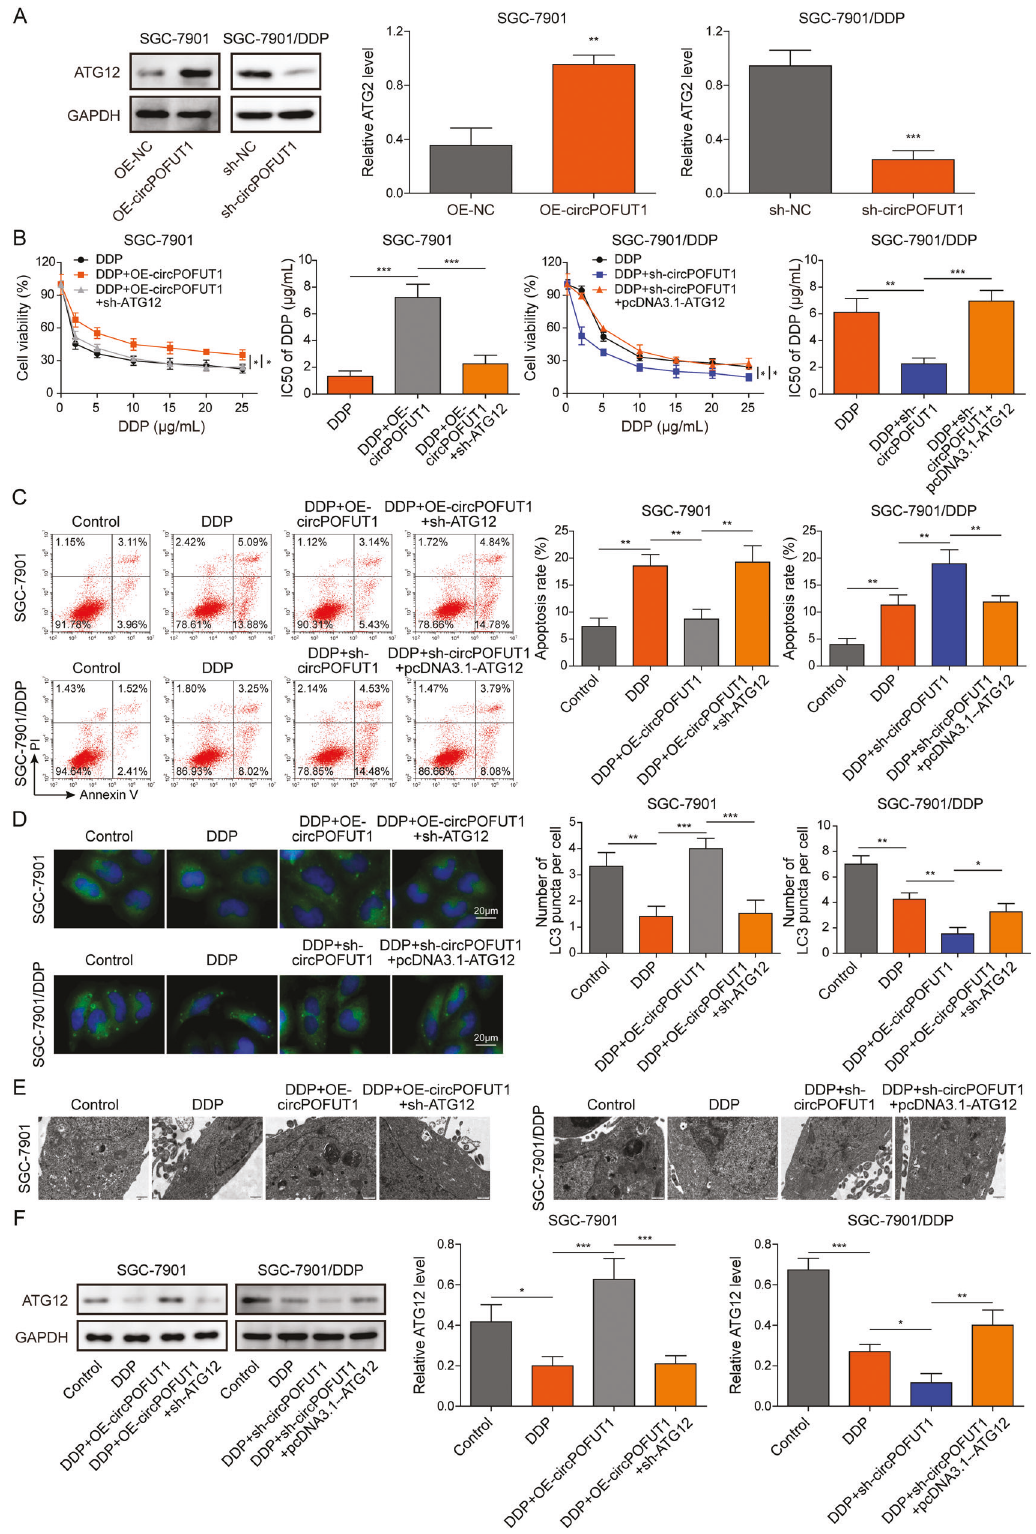
Fig. 6 ATG12 was a downstream effector of circPOFUT1 in regulating autophagy-associated chemoresistance. A The expression of ATG12 was examined by western blotting ( n = 3). B Cell viability analysis after DDP treatment ( n = 3). C Cell apoptosis analysis ( n = 3). D IF staining of LC3 (Green; Scale bar, 20 µm; Nuclei, Blue). E Autophagosomes were observed by electron microscope. F The expression of ATG12 was assessed by western blotting ( n = 3). * P < 0.05, ** P < 0.01 and *** P < 0.001.